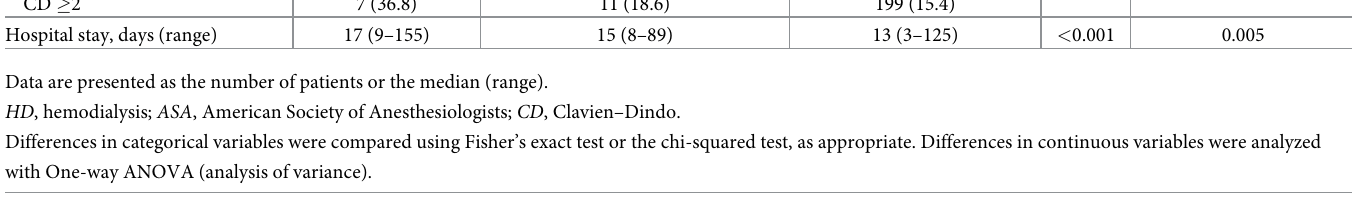
Table 1 lists the clinicopathological characteristics of the 1372 patients. The study